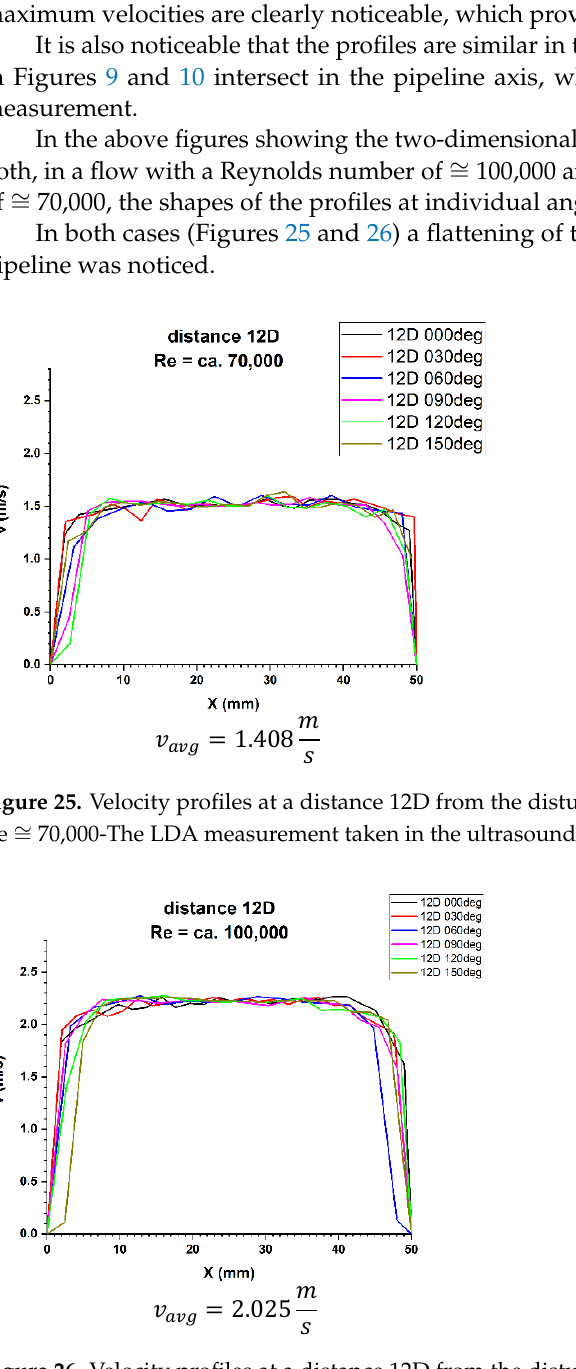
Figure 24. Projection on the velocity block at the distance 12D from the disturbance with marked cross-sections for Re ≅ 100,000.